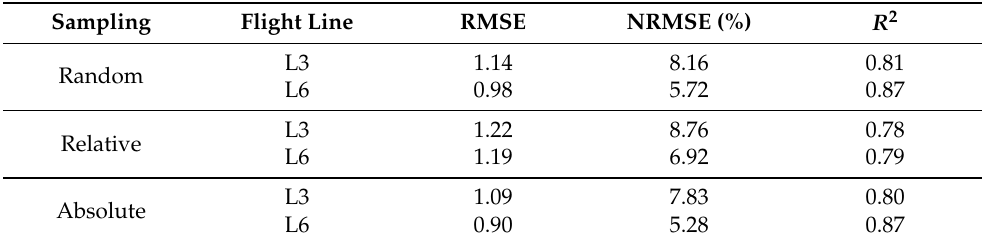
Table 3. Determined model performance for unknown flight lines based on different